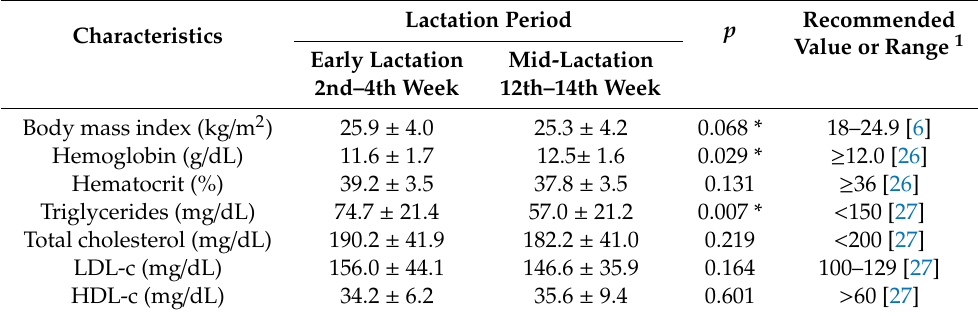
Table 1. General characteristics of adult Brazilian lactating women in early- (2nd to 4th week) and mid-lactation (12th to 14th week) ( n =